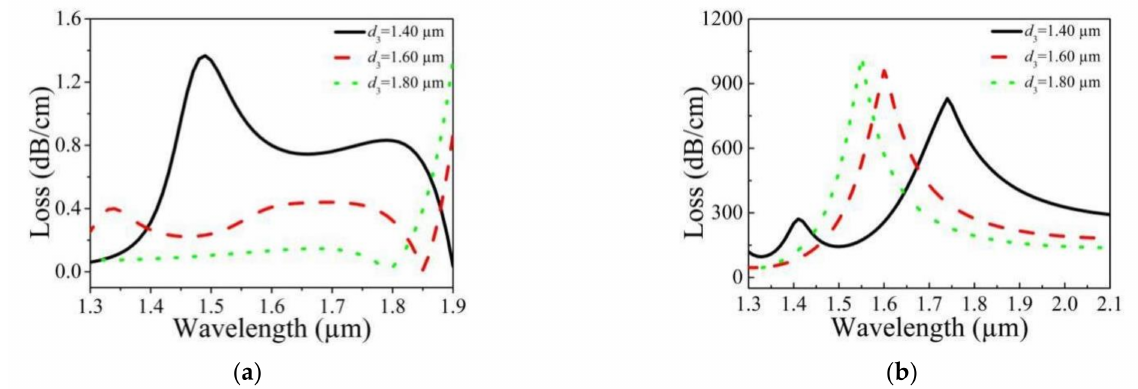
Figure 4. Loss of ( a ) X-polarized and ( b ) Y-polarized CM varied with d 3 = 1.40, 1.60, 1.80 µ m and d 1 = 2.40 µ m, d 2 = 1.38 µ m, d 4 = 2.20 µ m, t = 25.60